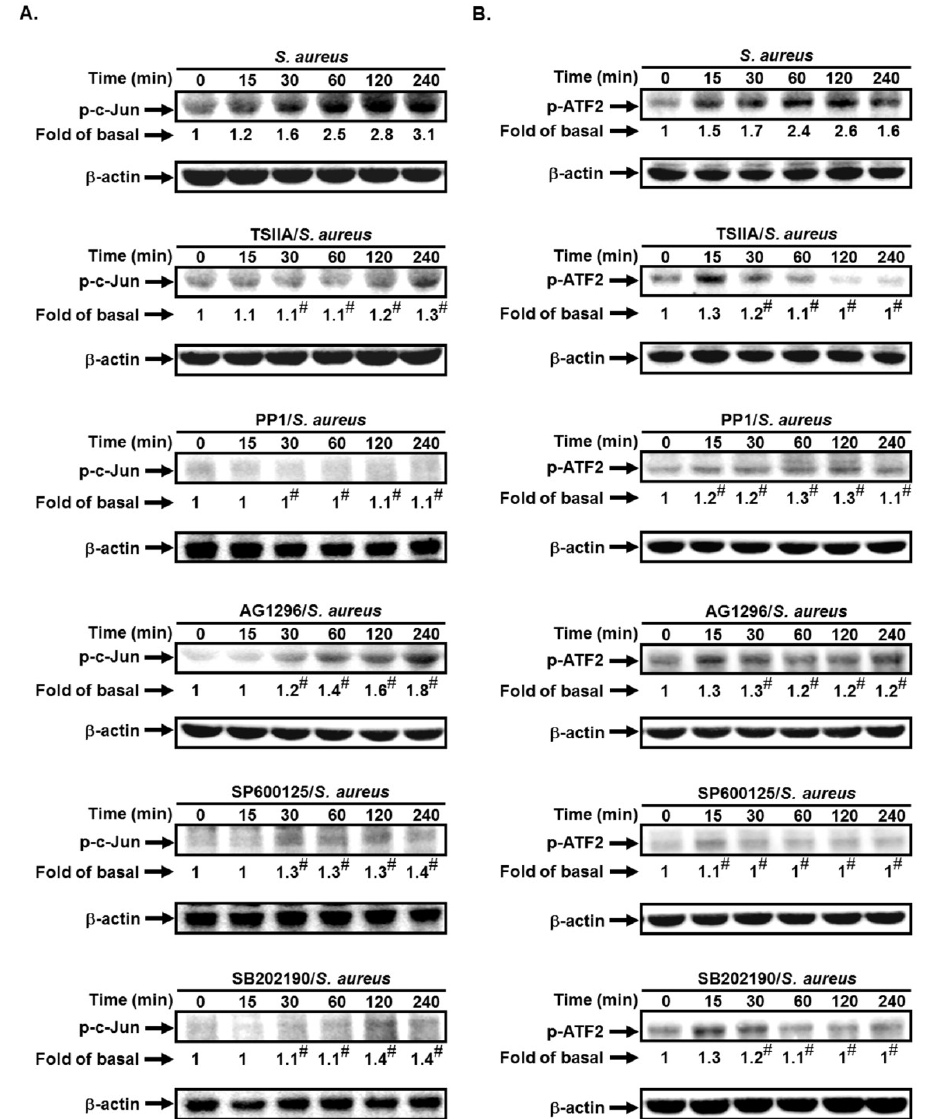
Figure 5. S. aureus induces AP-1 activation via c-Src/PDGFR/JNK1/2 and p38 MAPK pathways. Cells were pretreated without or with PP1, AG1296, SP600125, or SB202190 for 1 h, and then incubated with S. aureus for the indicated times. The expression of ( A ) phospho-c-Jun and ( B ) phospho-ATF2 was determined by Western blot. n = 3–4, # p < 0.01, as compared with the cells exposed to S. aureus alone. 2.6. Resveratrol Inhibits S. aureus-Induced VCAM-1 Expression and Inflammatory Signaling Pathways shown to inhibit inflammation [8]. First, we investigated whether resveratrol could inhibit S. aureus -